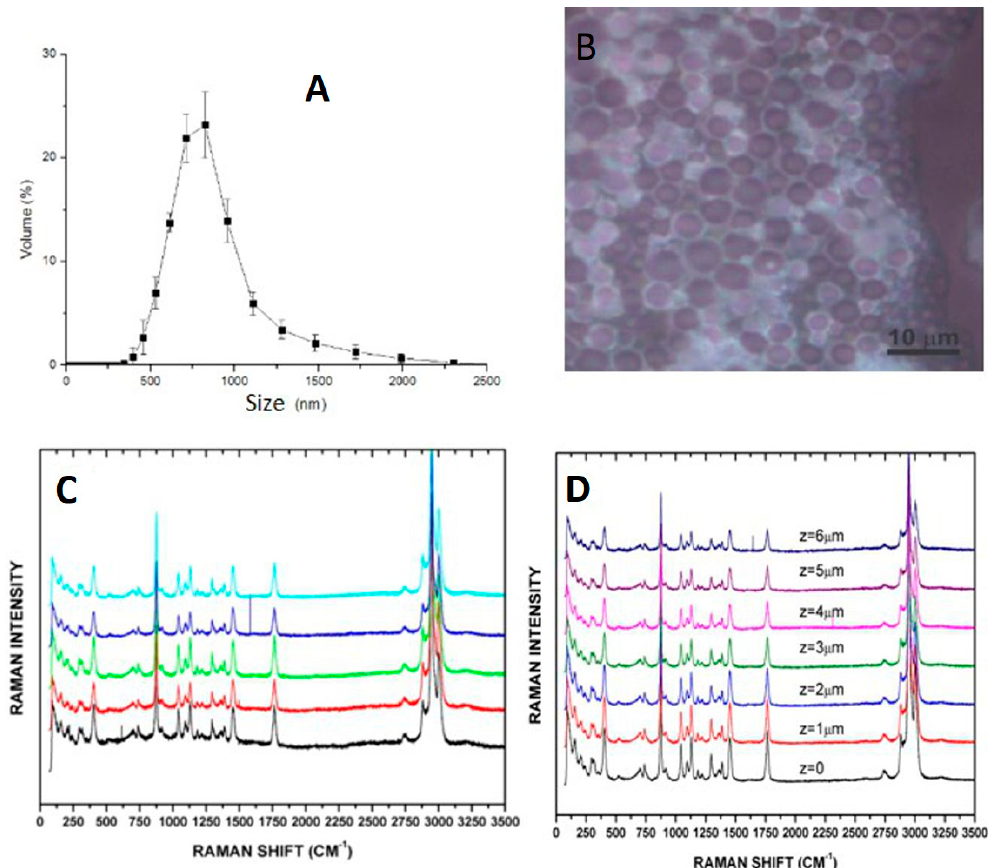
Figure 2. ( A ) Dynamic light scattering (DLS) size distribution of giant polymeric nanoparticle (GPPM). ( B ) Raman analysis corroborating the monomodal behavior. ( C ) Raman analysis showing the system overview and varying in axis y and Z ( D ) corroborating the uniformity of the microparticles tested and the emptiness state of the nanoparticle system.